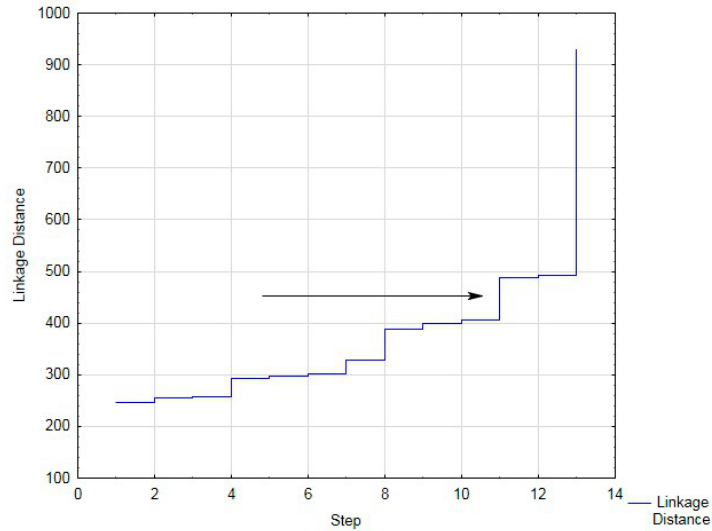
Figure A4. The plot of linkage distances across steps for cluster analysis of physical activities the children participated in. The arrow indicates the cut-off point and is equal to the distance of 450.